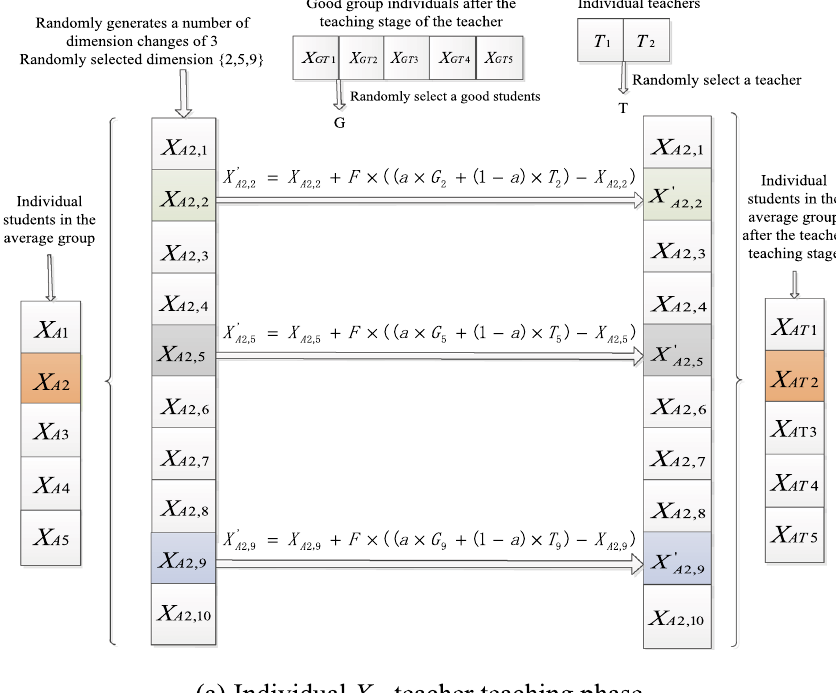
Figure 4. Subspatial learning mode of teacher teaching stage of average group individual X A2